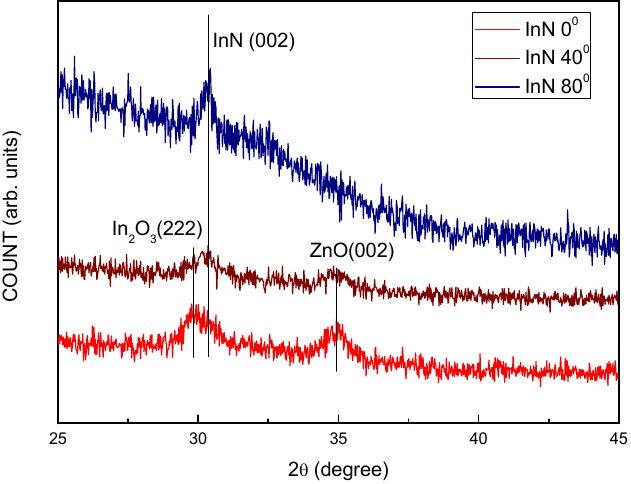
Figure 4. XRD pattern of the OAD-InN films deposited with various oblique